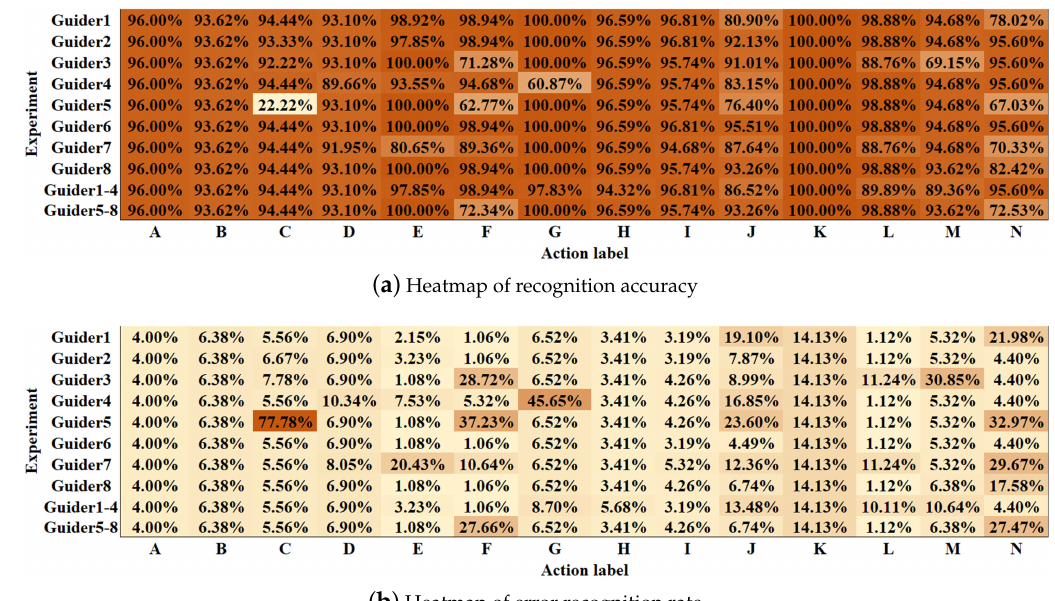
Figure 9. Heatmap of